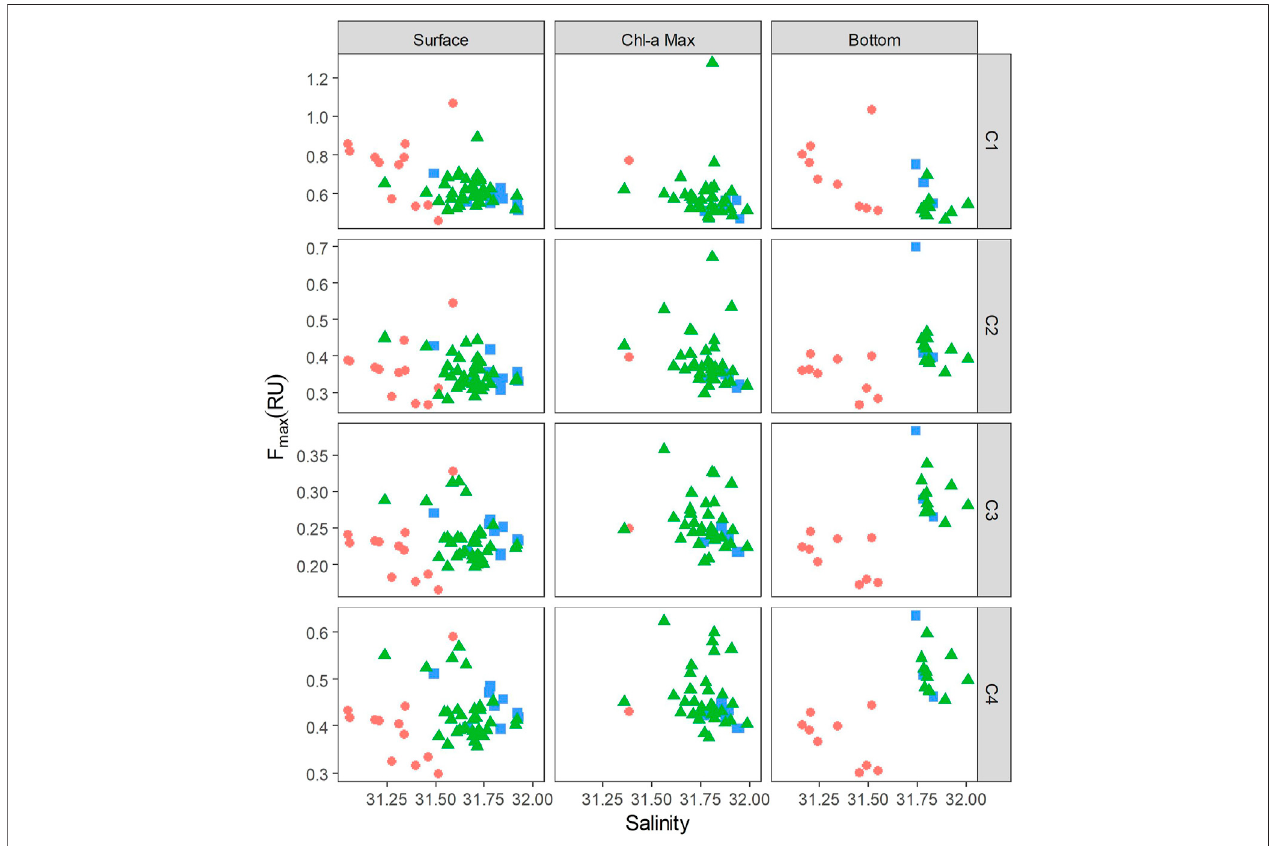
FIGURE 9 | Four PARAFAC components in samples with salinity in the range of 31 – 32 in different layers of three bays. Samples from Jiaozhou Bay are marked by red circles), samples from Sishili Bay are marked by green triangles, and samples from Taozi Bay are marked by blue squares.